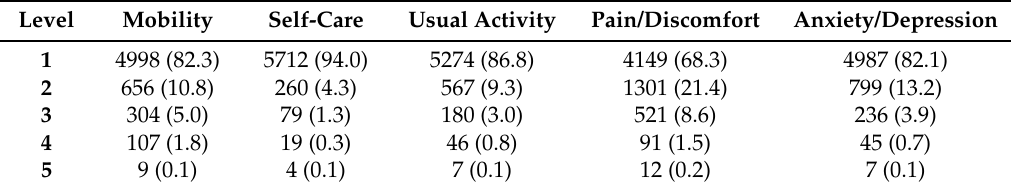
Table 2. Answer frequencies based on dimension, aggregated sample.